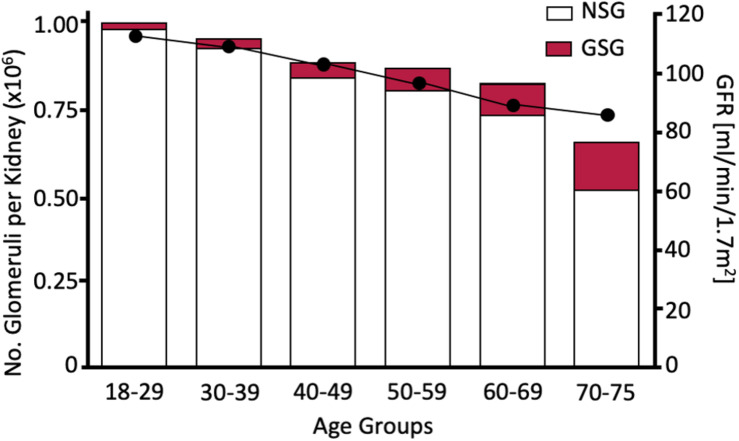
Age dependent increase in glomerulosclerotic nephrons (GSG) and decrease in non-sclerotic nephrons (left axis) and GFR. Since the total nephron population declines to <80% of the population measured in the 18–29 age group nephrons must have disappeared as well as becoming sclerotic. Redrawn from Denic et al. (2017).